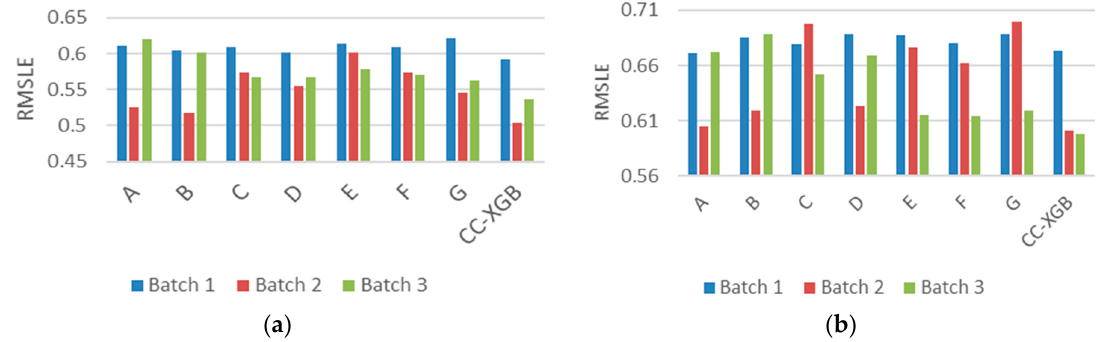
Figure 7. Performance of different feature combinations. ( a ) represents the rental demand and ( b ) represents the drop-off one.